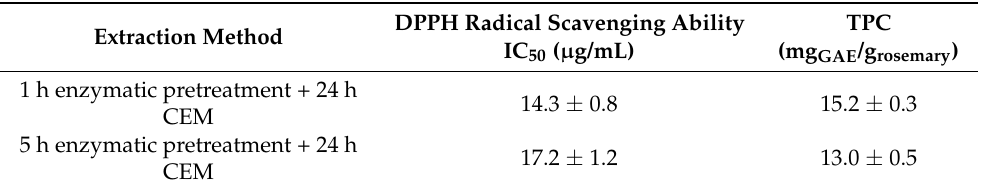
Table 5. TPC (mgGAE/g) and DPPH radical scavenging ability [IC 50 ( µ g/mL)] of the extracts obtained by enzyme pretreatment followed by conventional extraction.